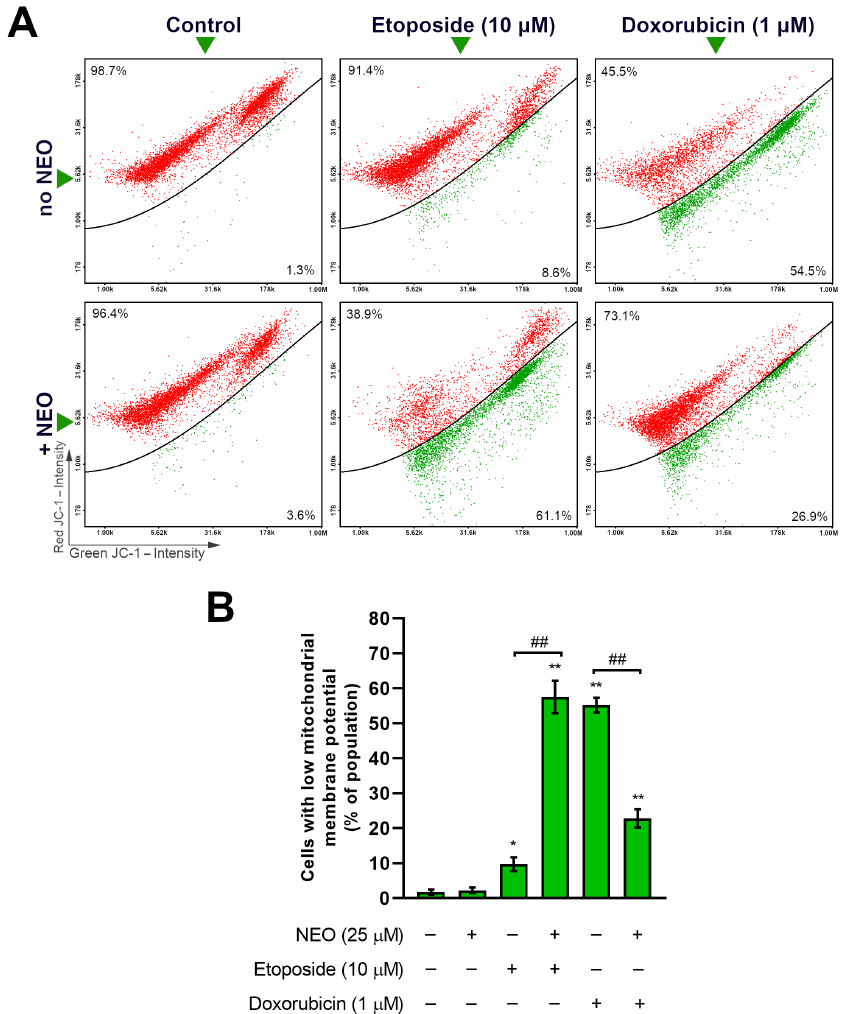
Figure 5. The assessment of the membrane mitochondrial potential in SW1783 cells incubated for 48 h with doxorubicin (1 μM) or etoposide (10 μM) alone and their mixes with NEO (25 μM). ( A ) Representative scatter plots showing cell population consisting of two subpopulations—cells with high mitochondrial membrane potential (red) and cells with low mitochondrial membrane potential (green). ( B ) Bar graph presenting mean values ± SD of the percentage of cells with decreased mitochondrial membrane potential from three independent experiments. * p < 0.05, ** p < 0.001 vs. control; ## p < 0.001 for comparisons between groups; ns—non-significant difference.